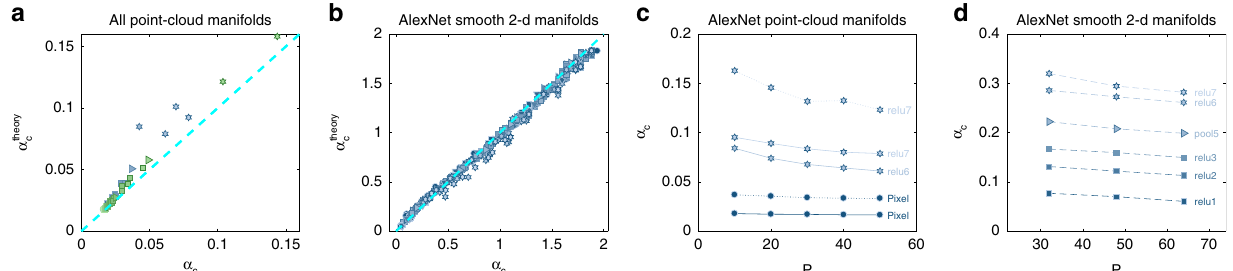
Fig. 9 Theoretical predictions. a Comparison of numerically measured capacity ( x -axis) with the theoretical prediction ( y -axis) for AlexNet, VGG-16 at different layers along the hierarchy (top 10% point-cloud manifolds). b Comparison of numerically measured capacity ( x -axis) with the theoretical prediction ( y -axis) for AlexNet at different layers along the hierarchy and different levels of manifold variability (smooth 2-d manifolds). c Numerically measured capacity ( y -axis) at different number of objects ( x -axis) for point-cloud manifolds at different layers (dashed line: top 10% manifolds; dotted line: top 5% manifolds). d Numerically measured capacity ( y -axis) at different number of objects ( x -axis) for smooth 2-d shear manifolds. Marker shape represents layer type (circle — pixel layer, square — convolution layer, right-triangle — max-pooling layer, hexagon — fully connected layer, down-triangle — local normalization layer). Color (blue — AlexNet, green — VGG-16) changes from dark to light along the